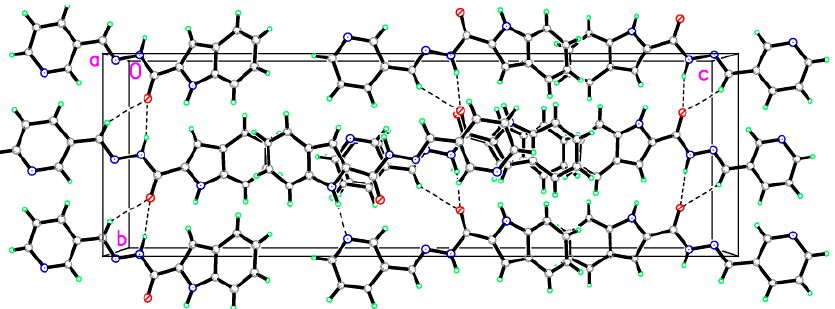
Figure 2. ORTEP diagram of the titled compound 11 drawn at 50% ellipsoids for non-hydrogen atoms.